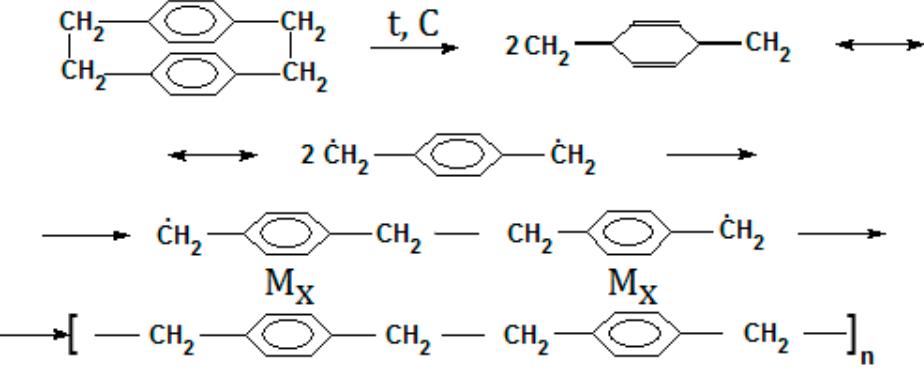
Figure 11. The scheme of the para-xylylene polymerization in triple metal-containing co-condensates.